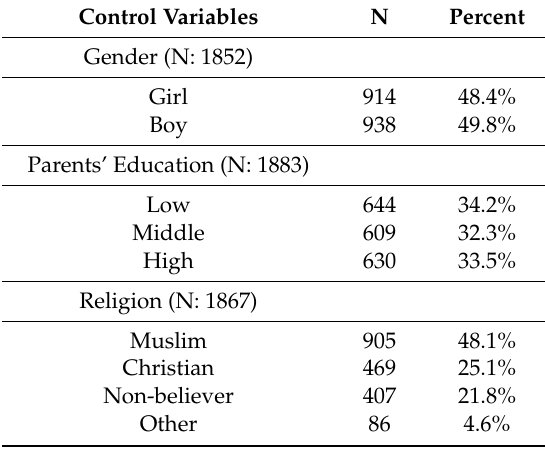
Table 4. Scale descriptors of control variables: gender, parents’ education, religion, origin and school